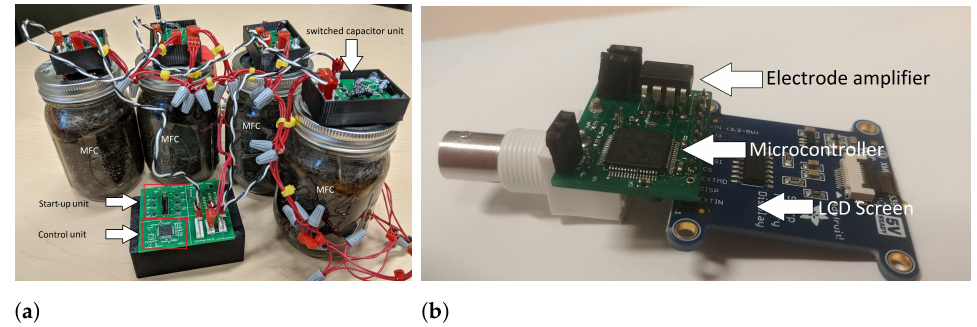
Figure 6. Experimental setup: ( a ) a full BERS system with in-house designed printed circuit boards; and ( b ) a full pH system with in-house designed printed circuit boards. Table 1. Reported current consumption of each